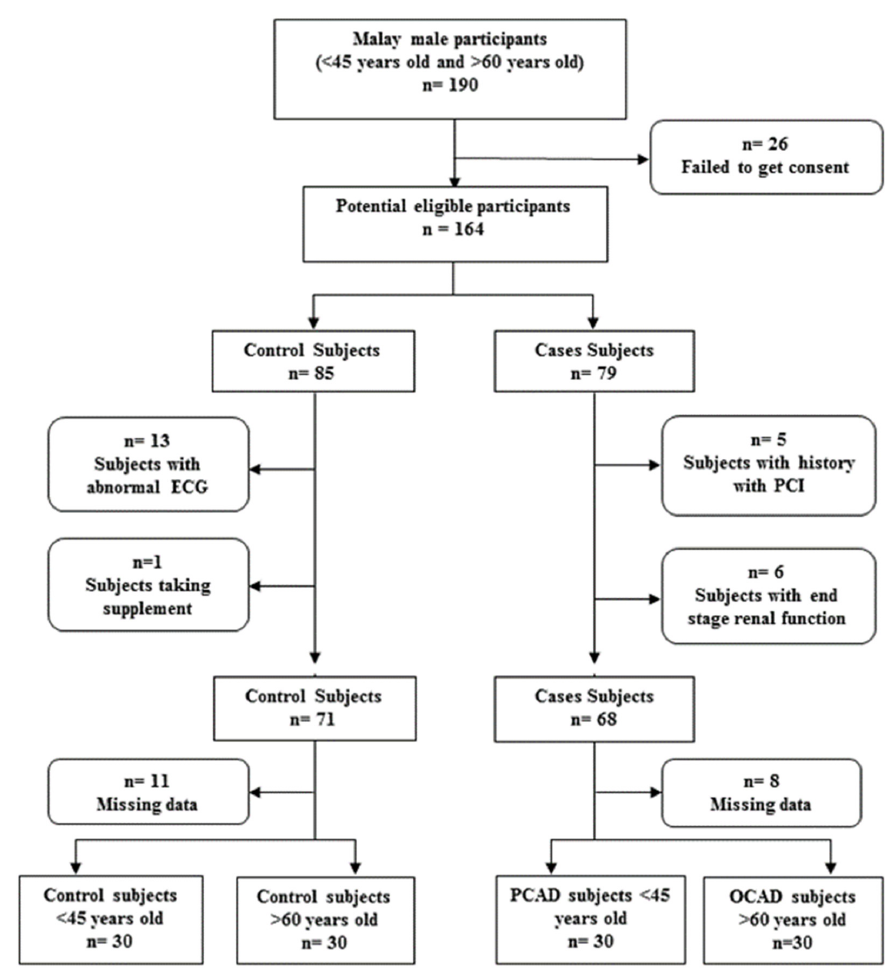
Figure 1. Flow chart for subject selection. Final number of subjects selected was 30 for each